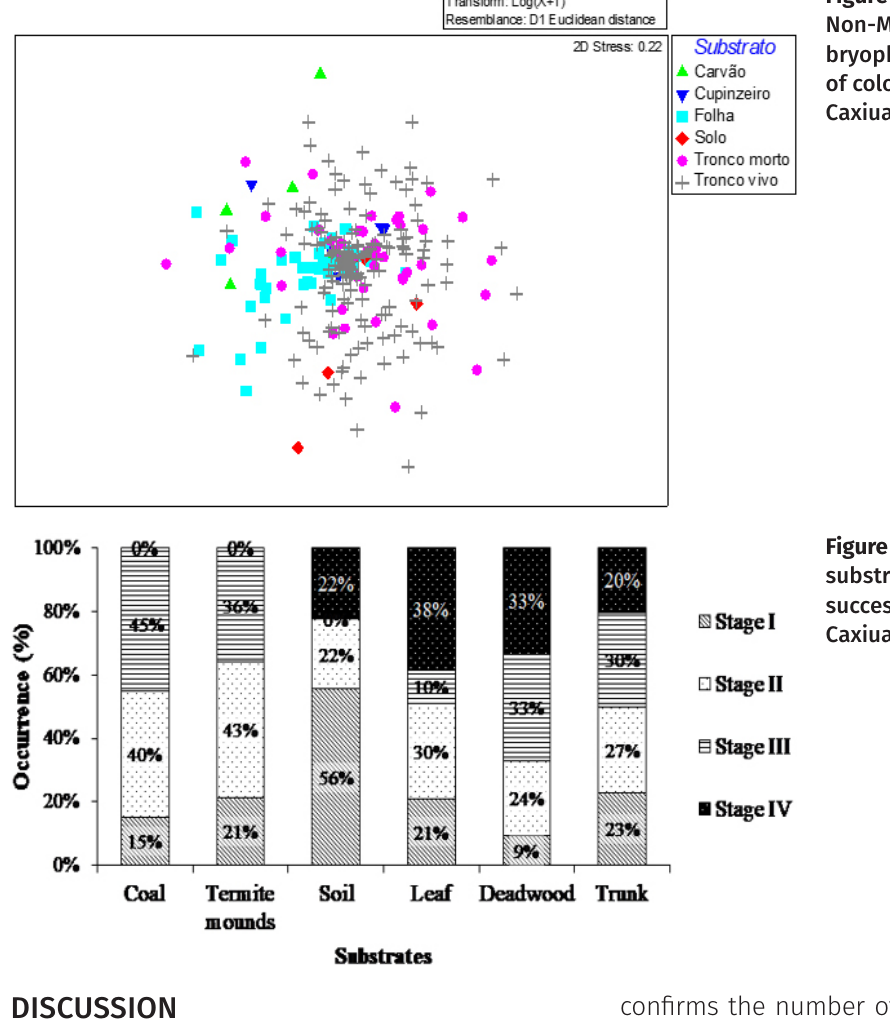
Figure 4. Colonization of different substrates across different successional stages in the Caxiuanã FLONA, Pará, Brazil.